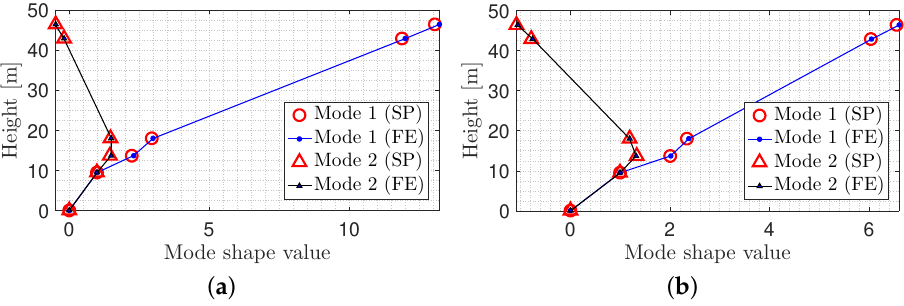
Figure 14. Comparison of the mode shapes obtained from Finite Element (FE) analysis and signal processing. ( a ) Lateral direction; ( b ) Longitudinal